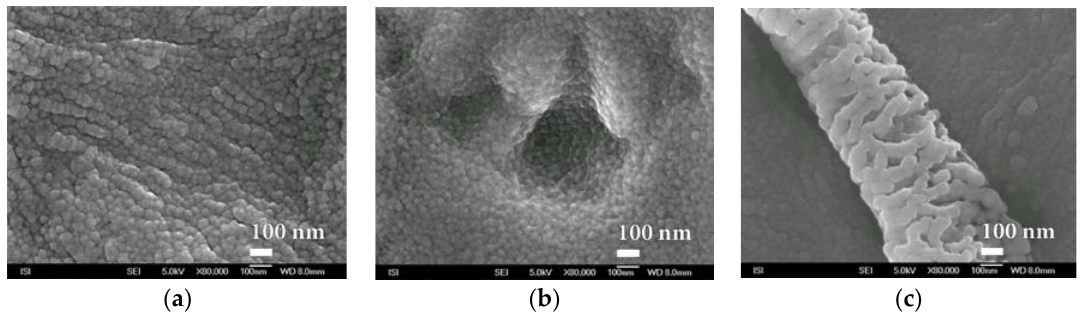
Figure 18. SEM micrographs of SiO x nanocoating substructure prepared by plasma deposition by HMDSO method on the PEVA foil at magnification of 80,000× of three different areas. ( a ) Typical surface morphology; ( b ) layer defect and ( c ) surface abnormality.